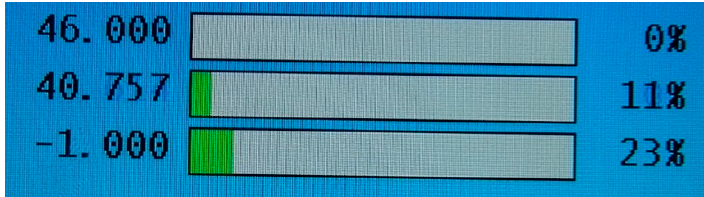
Figure 3. Screenshot from a CNC machine tool operator panel, showing the percentages of the required rated torque (on each axis) displayed by means of the current sensor (internal sensors, INS) measurements.